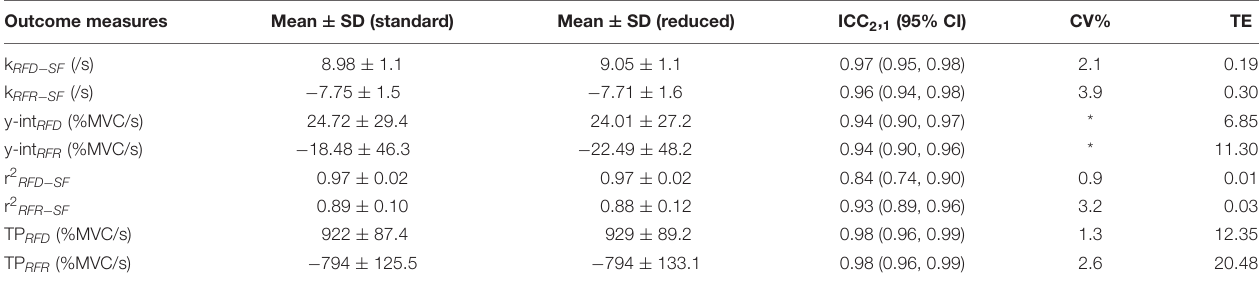
TABLE 2 | Descriptive statistics, validity measures, and Bland–Altman statistics of rate of force development scaling factor (RFD-SF) and rate of force relaxation scaling factor (RFR-SF) outcome measures based on the standard and the reduced measurement protocol ( n = 40). Outcome